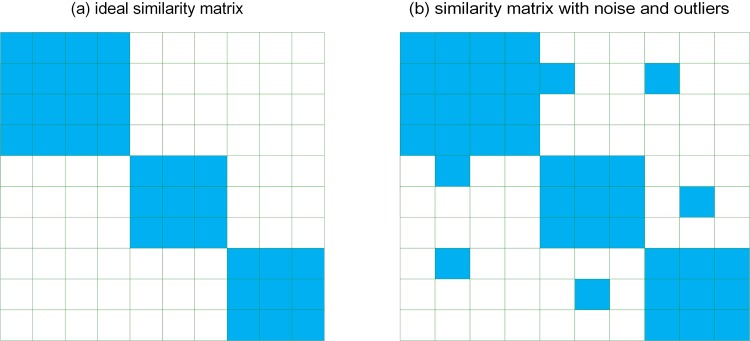
The examples of similarity matrices.The elements of zero values are illustrated with white and those of non-zero values are illustrated with blue.